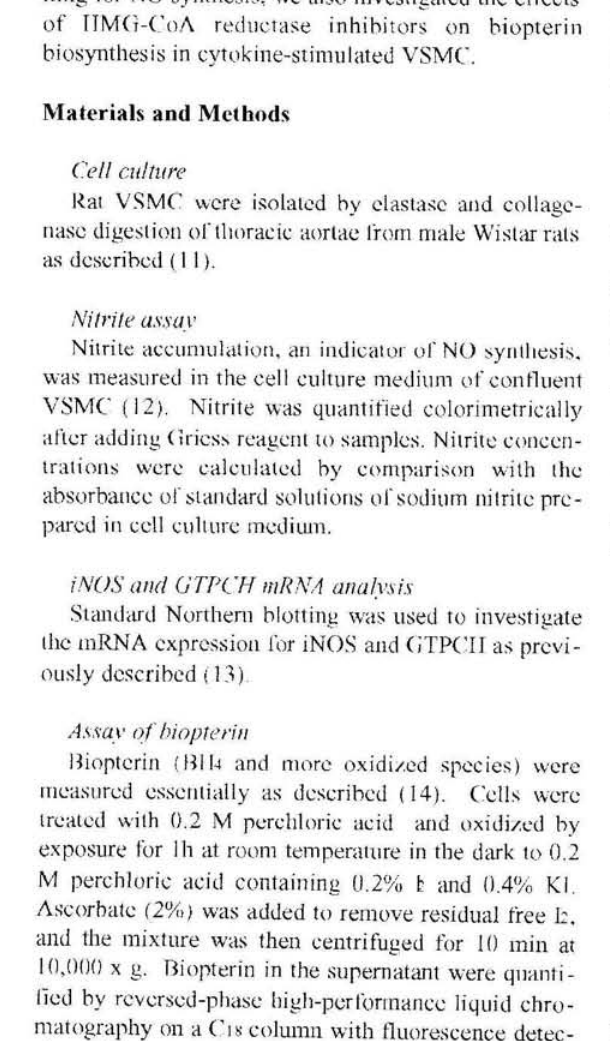
Figure 1 Effect of cervastatin or fluvastatin on nitrite production in IL-1- or IF-FTFN-stimulated rat VSMC. Cells were incubated with IP-1 (gray bars) or a com- bination of IL-1 and IFN (black bars) in the presence of cervastatin (Ceri, 5 μΜ) or fluvastatin (Flu, 25 μΜ) tor 24 h. then nitrite accumulation in media was meas- ured. with IL-1 in the presence of various concentrations of cervastatin or fluvastatin for 24 h. Data are means + s.e.m (n 6). *P<0.05 and **P<0.01 compared with control (IL-1/IFN